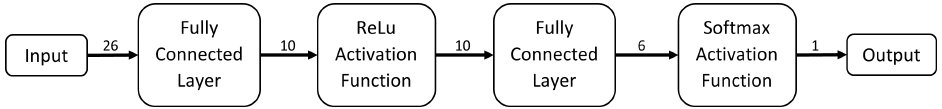
Figure 5. Structure of the neural network used for the classifier.